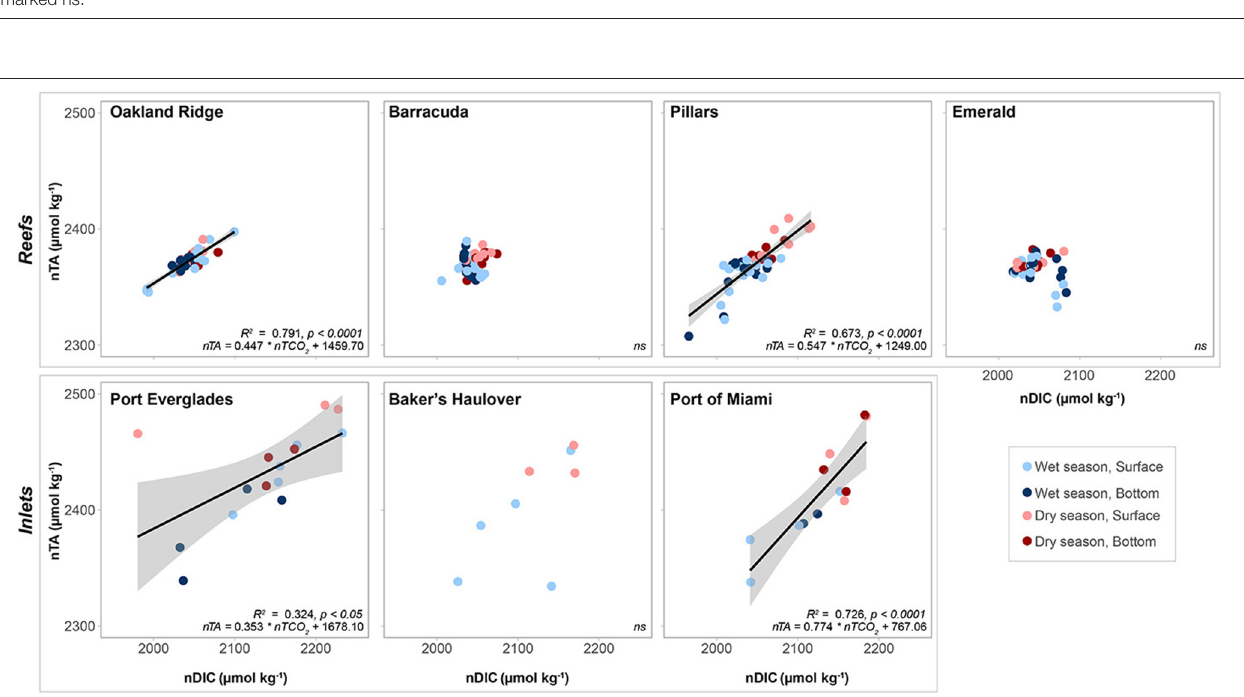
FIGURE 7 | Salinity normalized total alkalinity (nTA, µ mol kg − 1 ) as a function of salinity normalized dissolved inorganic carbon (nDIC, µ mol kg − 1 ).Lines represent linear regression, with error bars shown in gray. R 2 and p values, as well as the equation for each fitted line given for each sampling site where a significant relationship was observed. Non-significant ( p > 0.05) are marked ns. Data are divided into dry (red) and wet season (blue) at each of four reef and three inlet sampling sites. Darker colors represent samples taken above the benthos while lighter colors represent samples taken at the surface.